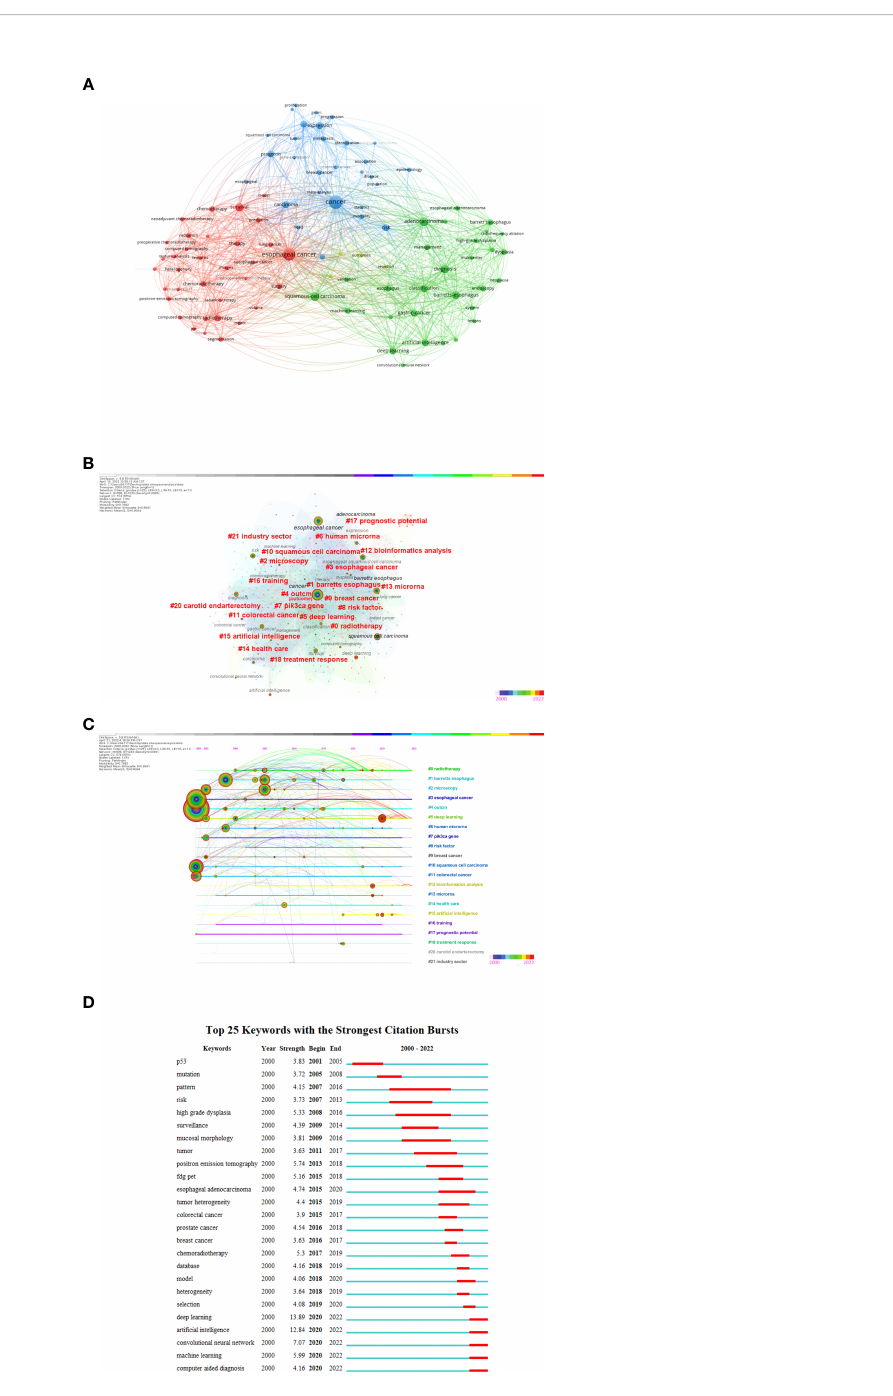
FIGURE 8 (A) The network visualization map of the 96 keywords with a frequency of no less than 15 times generated by using VOSviewer. (A) All the keywords could be clustered into 3 main clusters: #Cluster 1 (Cancer-AI-related study, red nodes), #Cluster 2 (Esophageal cancer AI-related study, blue nodes), and #Cluster 3 (Adenocarcinoma AI-related study, green nodes). (B) A landscape view of keyword cluster analysis generated by g-index (K = 25) per slice from 2000 to 20222. (LRF = 3.0, L/N = 10, LBY = 5, and e = 1.0). (C) CiteSpace visualization map of timeline view. The time evolution is indicated with different colored lines, and the nodes on the lines indicate the keyword clusters appearance. (D) CiteSpace visualization map of keywords with the strongest citation bursts from 2000 to